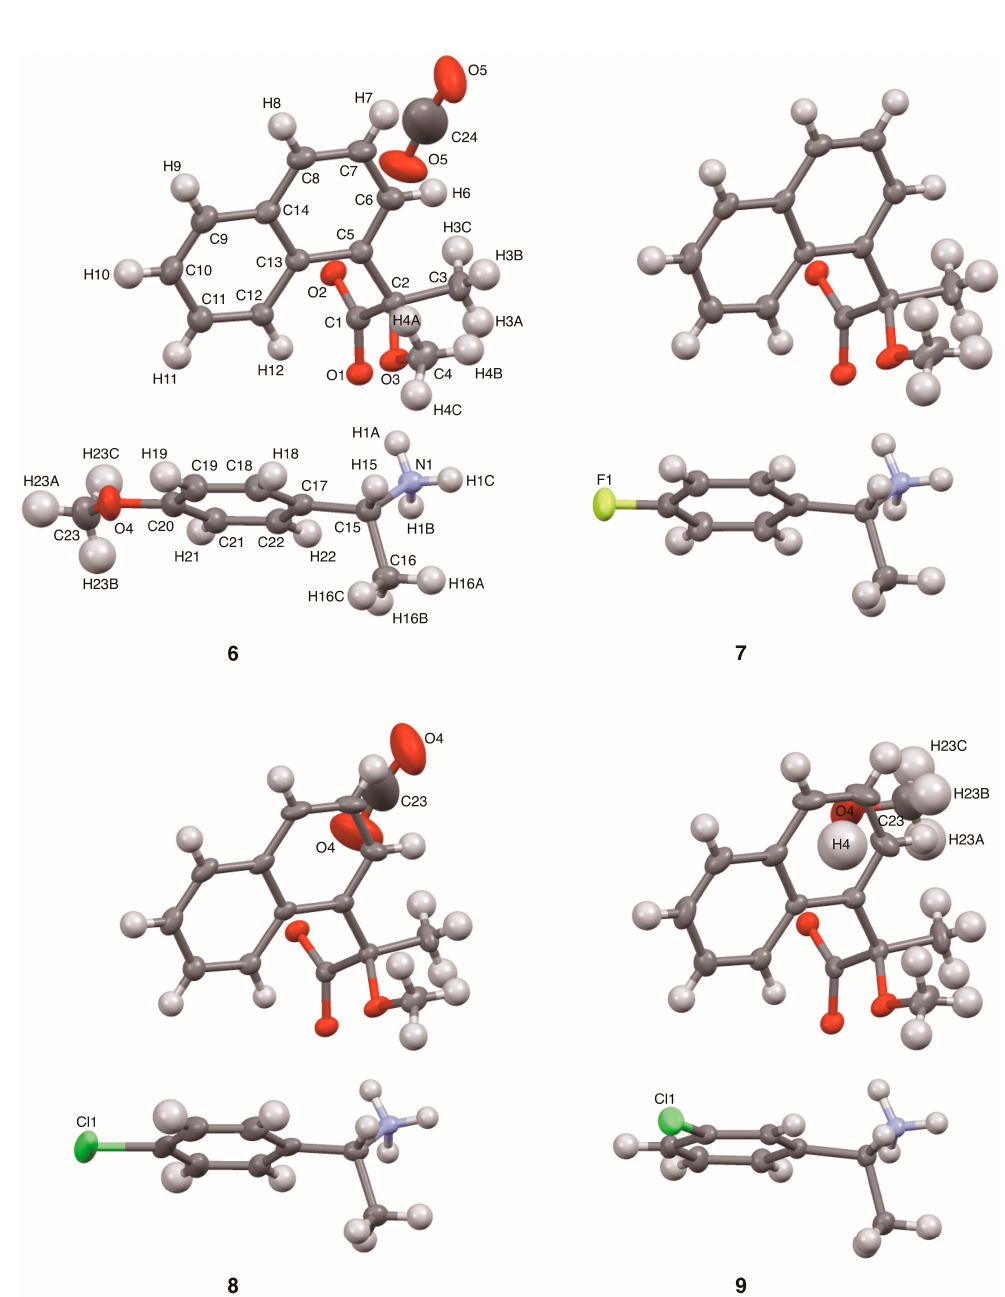
Figure 3. ORTEP diagrams of salts 6 – 9 with ellipsoids set at 50% probability. Crystals of salts 6 , 8 , and 9 were methanol solvates. The methanol molecules in salts 6 and 8 showed positional disorder. The atom labels for salt 6 were also used for the other salts except for the substituents and methanol